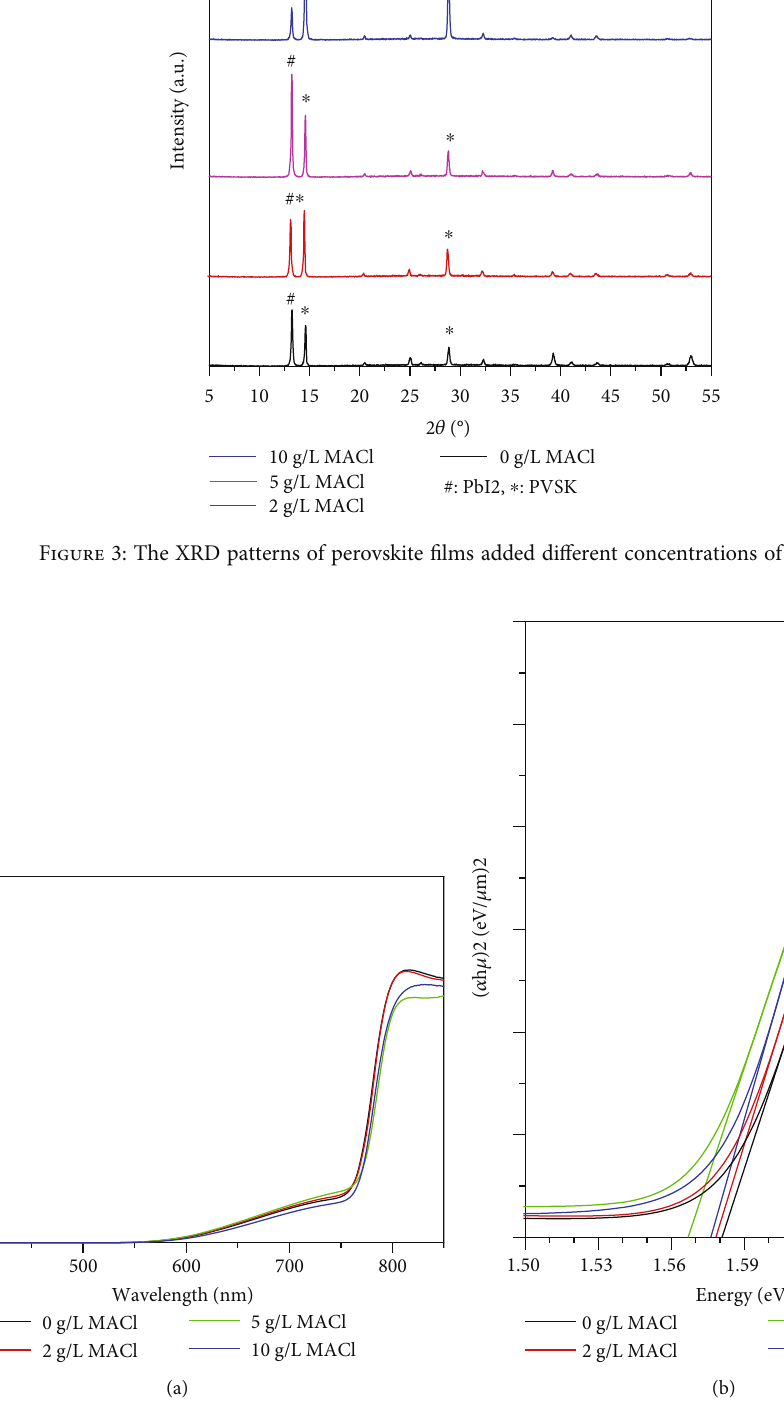
Figure 4: (a) The UV-vis spectra and (b) Tauc curves of perovskite fi lms added di ff erent concentrations of